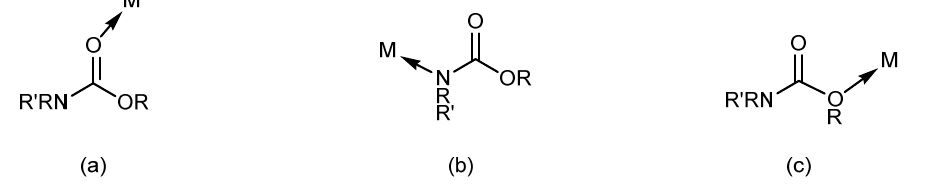
Figure 10. Co-ordination of urea to metal centers through ( a ) O-atom of the carbonyl, and ( b ) N-atom and ( c ) O-atom of ester moiety. (Reprinted with permission from Ref. [76], 2014, Elsevier)